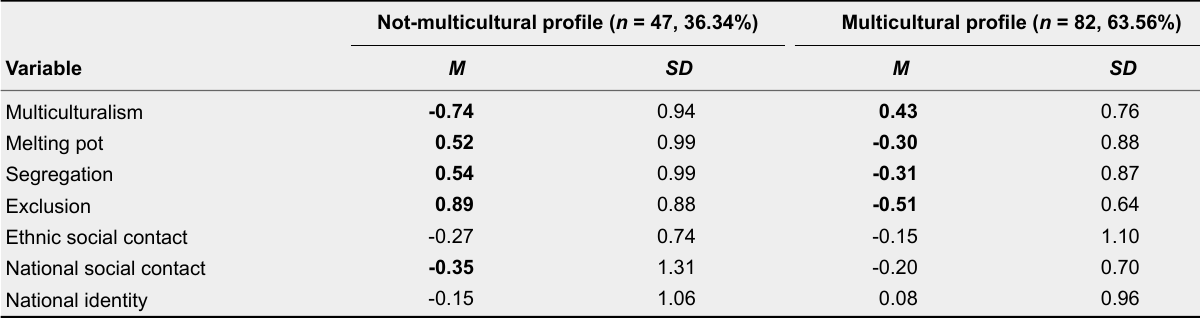
Means and Standard Deviations of Italians Acculturation Expectation Variables (Z-Scores) by Configuration (n =